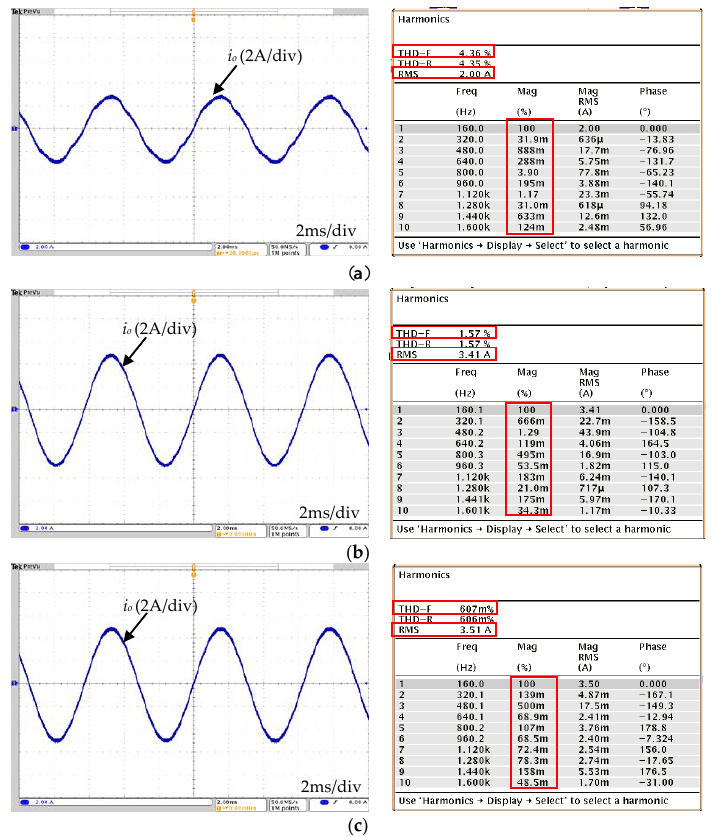
Figure 14. The current waveforms and their harmonic analysis results: ( a ) hard-switching inverter; ( b ) the ARSI with conventional control; and ( c ) the ARSI with proposed control